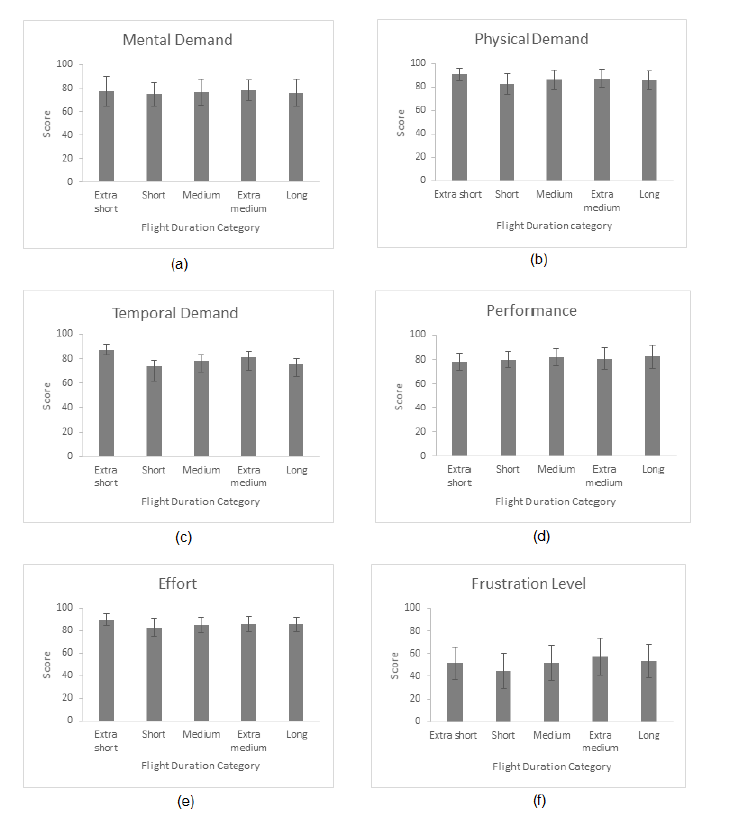
Figure 3. Mental workload of flight